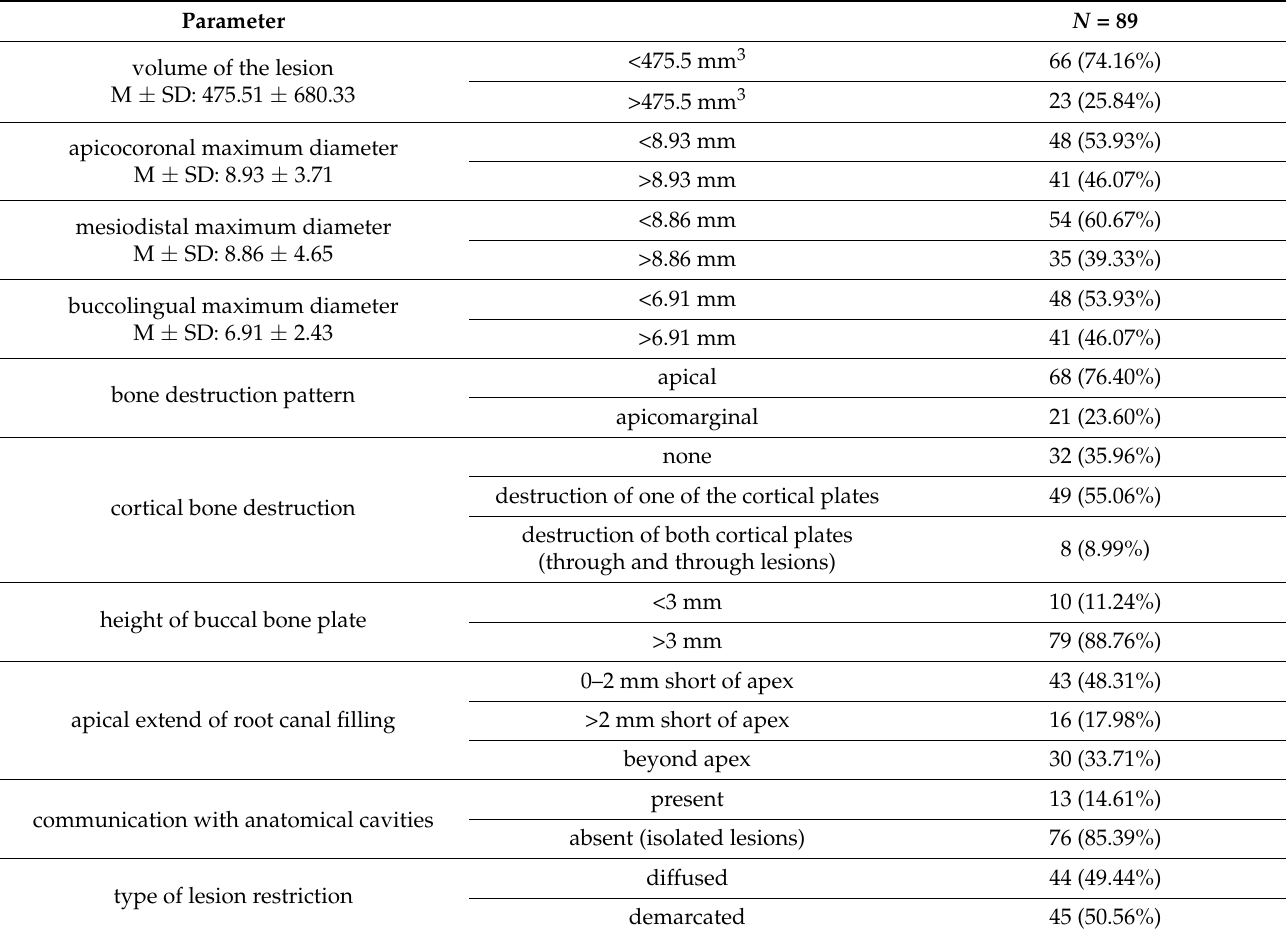
Table 2. Distribution of cases according to the tooth-related parameters (continuous variables are split at the mean